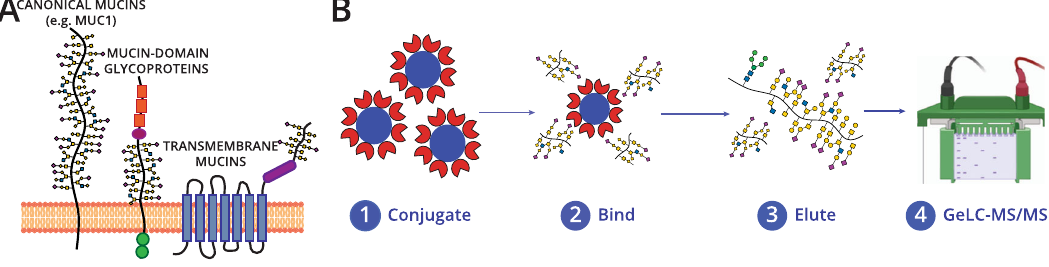
Fig. 1 Mucinomics platform for enrichment of mucin-domain glycoproteins in complex samples. A The mucinome comprises a variety of proteins that have a densely glycosylated mucin domain. Mucin domains are found in canonical mucins, mucin-domain glycoproteins, and even multi-pass transmembrane proteins. B Work fl ow for enrichment technique. StcE E447D beads were conjugated using reductive amination to POROS-AL 20 beads, followed by capping in Tris-HCl (1). Complex samples (lysate, ascites) were added to the beads and allowed to bind overnight (2), washed, and eluted by boiling in protein loading buffer (3). Samples were fractionated via one-dimensional gel electrophoresis and digested in-gel using trypsin (4); the gel electrophoresis chamber was created with